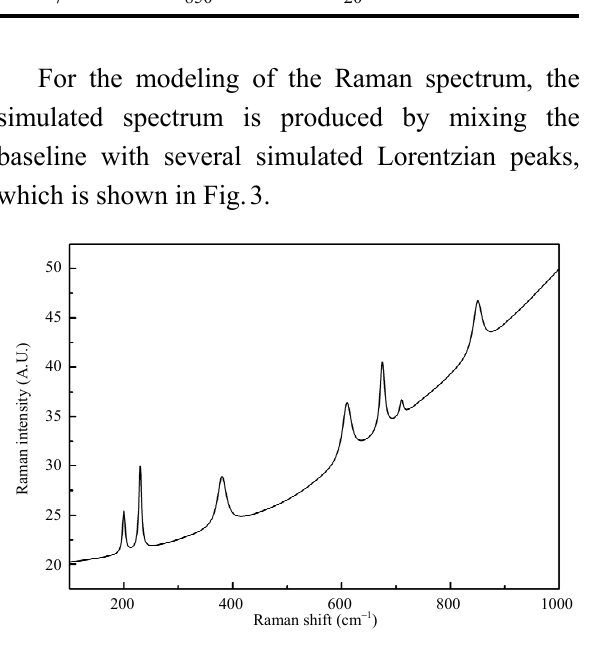
Fig. 3 Mathematical examples of simulated Raman spectrum superimposed on the baseline.